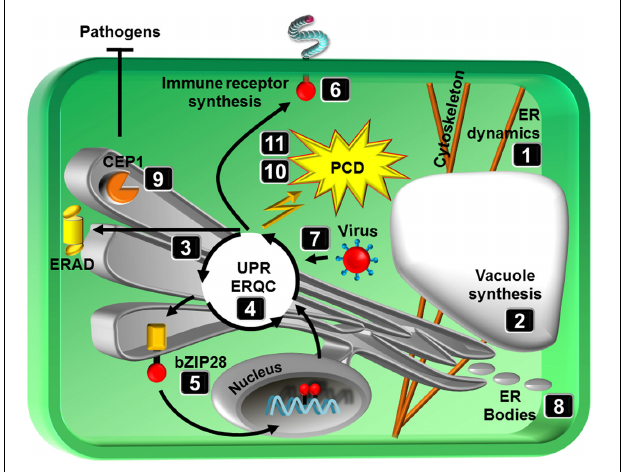
FIGURE 1 | Schematic representation of topics covered in the special issue. Numbers correspond to review articles as follows: (1) Griffing et al. (2014), ER network dynamics are differentially controlled by myosins XI-K, XI-C, XI-E, XI-I, XI-1, and XI-2, (2) Viotti (2014), ER and vacuoles: never been closer, (3) Li and Liu (2014), Endoplasmic reticulum-mediated protein quality control in Arabidopsis, (4) Ruberti and Brandizzi (2014), Conserved and plant-unique strategies for overcoming endoplasmic reticulum stress, (5) Srivastava et al. (2014), Stress sensing in plants by an ER stress sensor/transducer, bZIP28, (6) Tintor and Saijo (2014), ER-mediated control for abundance, quality, and signaling of transmembrane immune receptors in plants, (7) Verchot (2014), The ER quality control and ER associated degradation machineries are vital for viral pathogenesis, (8) Nakano et al. (2014), ER bodies in plants of the Brassicales order: biogenesis and association with innate immunity, (9) Höwing et al. (2014), Endoplasmic reticulum KDEL-tailed cysteine endopeptidase 1 of Arabidopsis (AtCEP1) is involved in pathogen defense, (10) Williams et al. (2014), When supply does not meet demand-ER stress and plant programmed cell death, (11) Cai et al. (2014), Endoplasmic reticulum stress-induced PCD and caspase-like activities